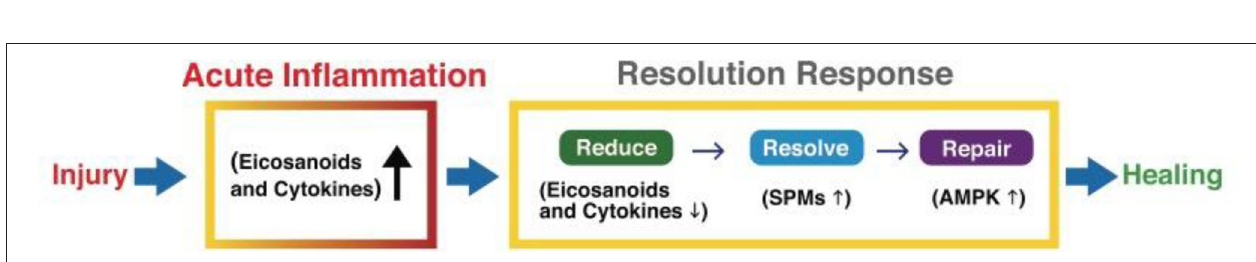
Frontiers in Nutrition |